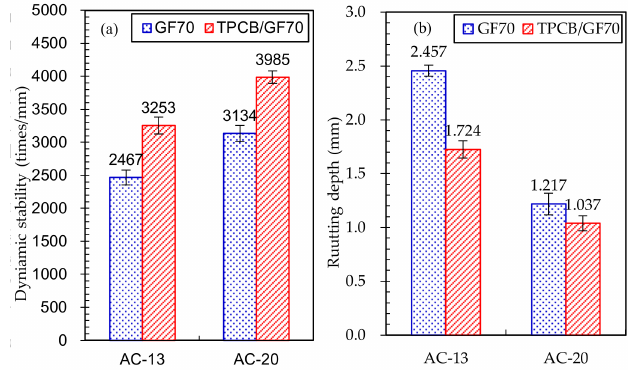
Figure 8. DS ( a ) and rutting deeps ( b ) of GF70 and TPCB/GF70 asphalt mixtures.